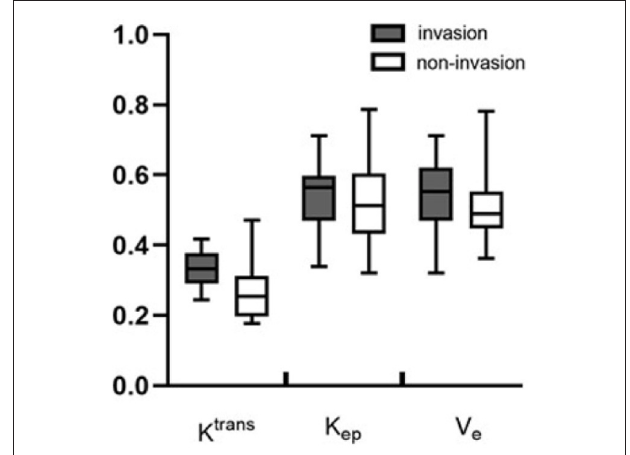
FIGURE 1 | Boxplots of the DCE-MRI parameters of K trans , K ep , and V e between the invasion and non-invasion